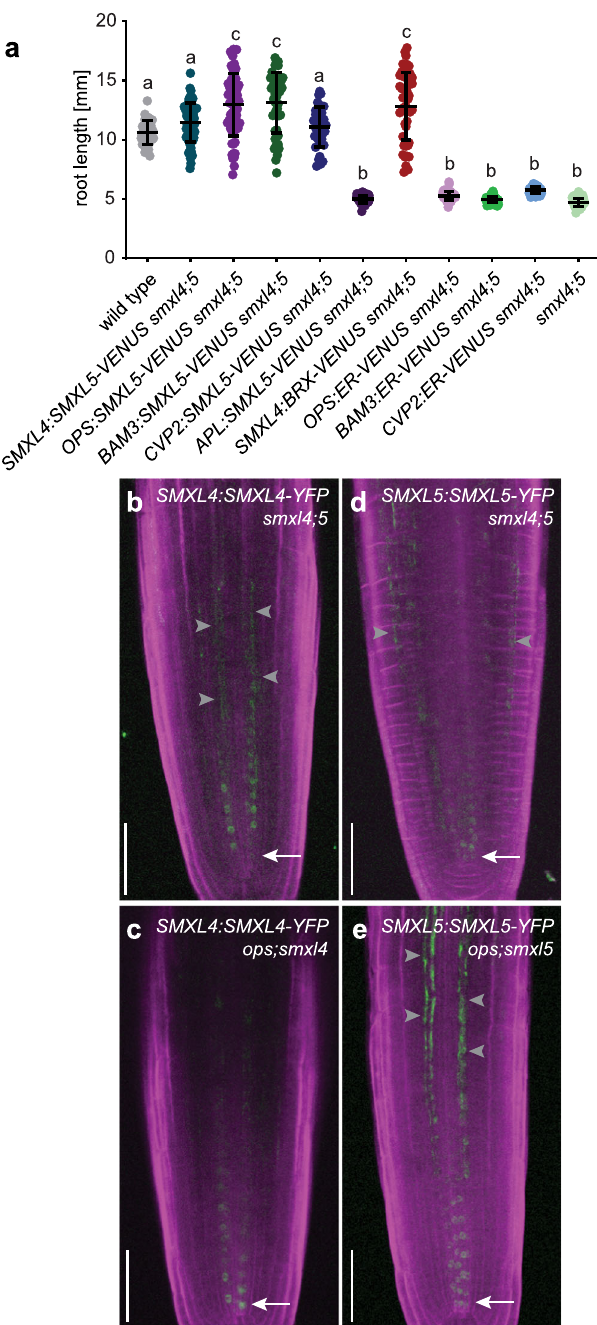
Fig. 2 | Analysis of interaction between SMXL4 , SMXL5, and other phloem reg- ulators. a Root length of 5-day-old plants. n between 36 (for CVP2:SMXL5- VENUS;smxl4;5 ) and 72 (for APL:SMXL5-VENUS;smxl4;5 ), see Source Data File for exactsample sizes of all groups. Statistical groups determined by one-wayANOVA andposthocTukey ’ stest(95%CI).Shownisonerepresentativeexperimentofthree repetitions. b – e Comparison of SMXL4:SMXL4-YFP and SMXL5:SMXL5-YFP reporter activities in smxl4;smxl5 and smxl;ops mutants. Arrows indicate the signals closest totheQC.Grayarrowheadsindicatebackgroundsignalduetotissuedamage.Scale bars represent 50 µ m. Ten samples each were analyzed with similar results.